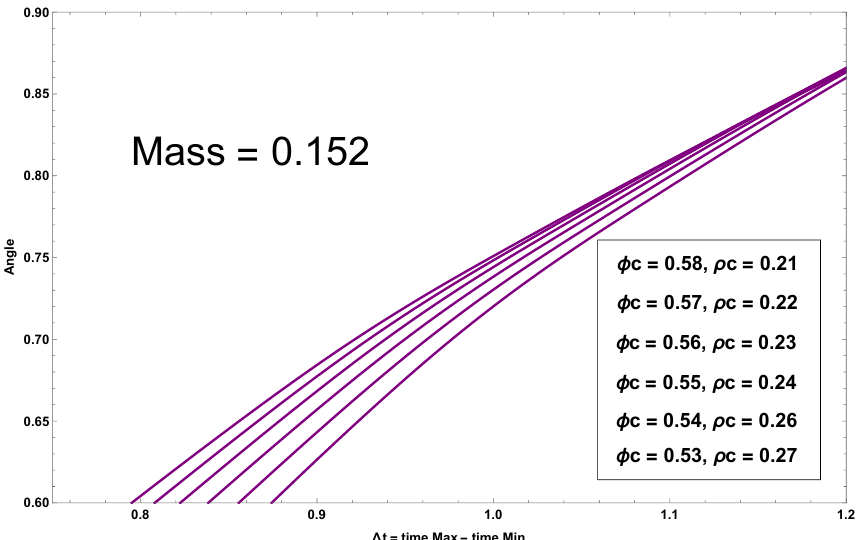
Figure 5. Close-up to the plot of the angle (cid:12) vs (cid:1) t for solutions with di(cid:11)erent values of (cid:26) c and (cid:30) c , and total mass M Total = 0 : 152.